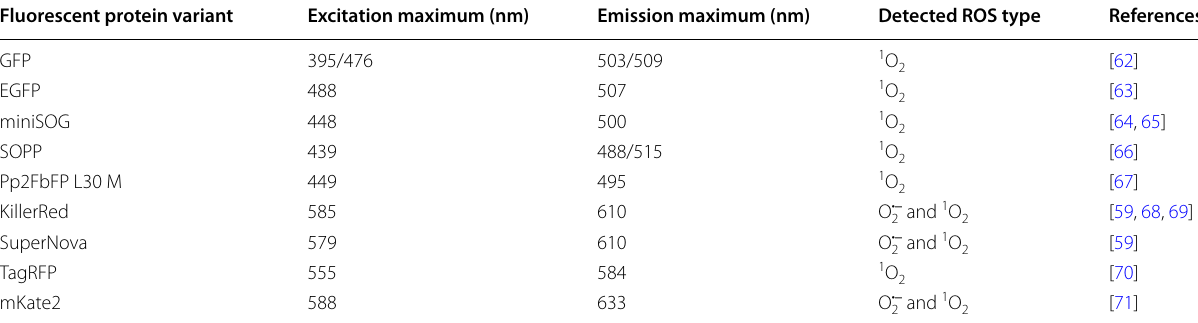
Table 1 Optical excitation and emission of phototoxic fluorescent proteins and their detected ROS types Fluorescent protein